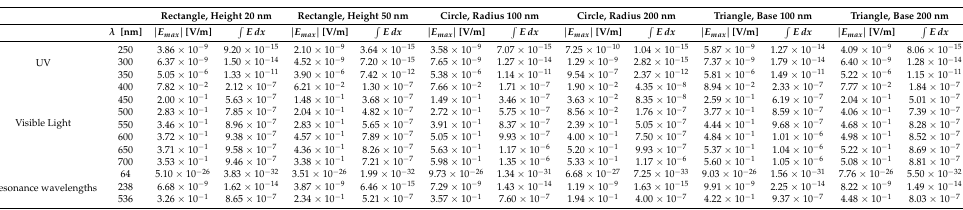
Table A8. Summary table of the results obtained for the gold nanostructures—Probe 2.